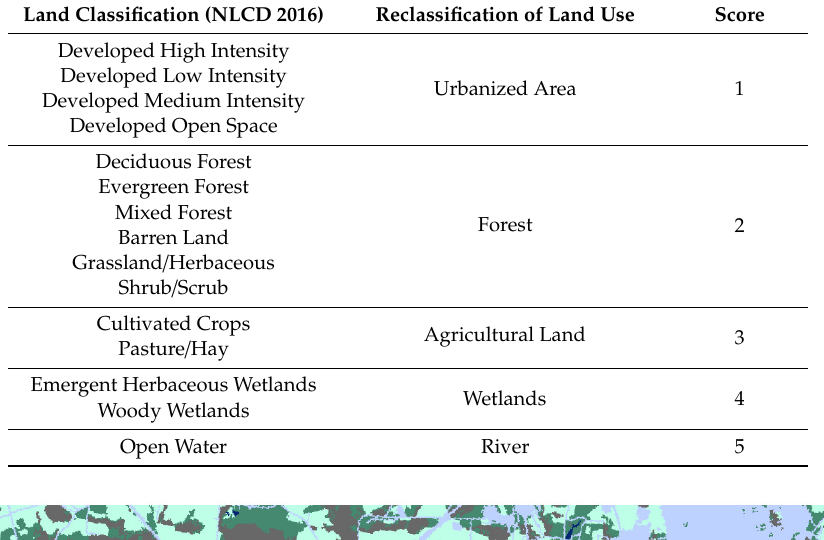
Table 4. Reclassification of the land use data obtained from NLCD (2016) for the study area near Kinston with their assigned value for vulnerability assessment.